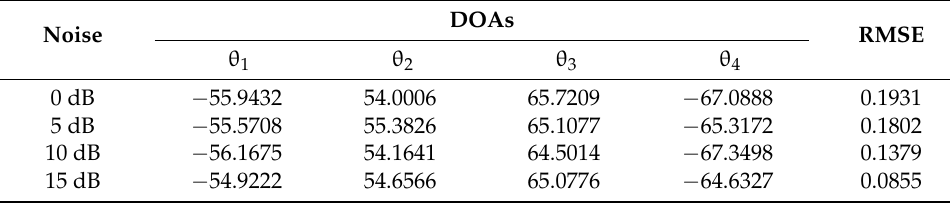
Table 5. DOA Estimation for Four Targets for N = 6 and M = 6 with Different Noises. Noise